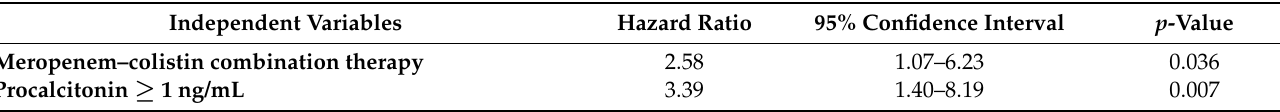
Table 4. Cox proportional hazards regression analysis of predictors associated with in-hospital mortality in patients with carbapenem-resistant Acinetobacter baumannii